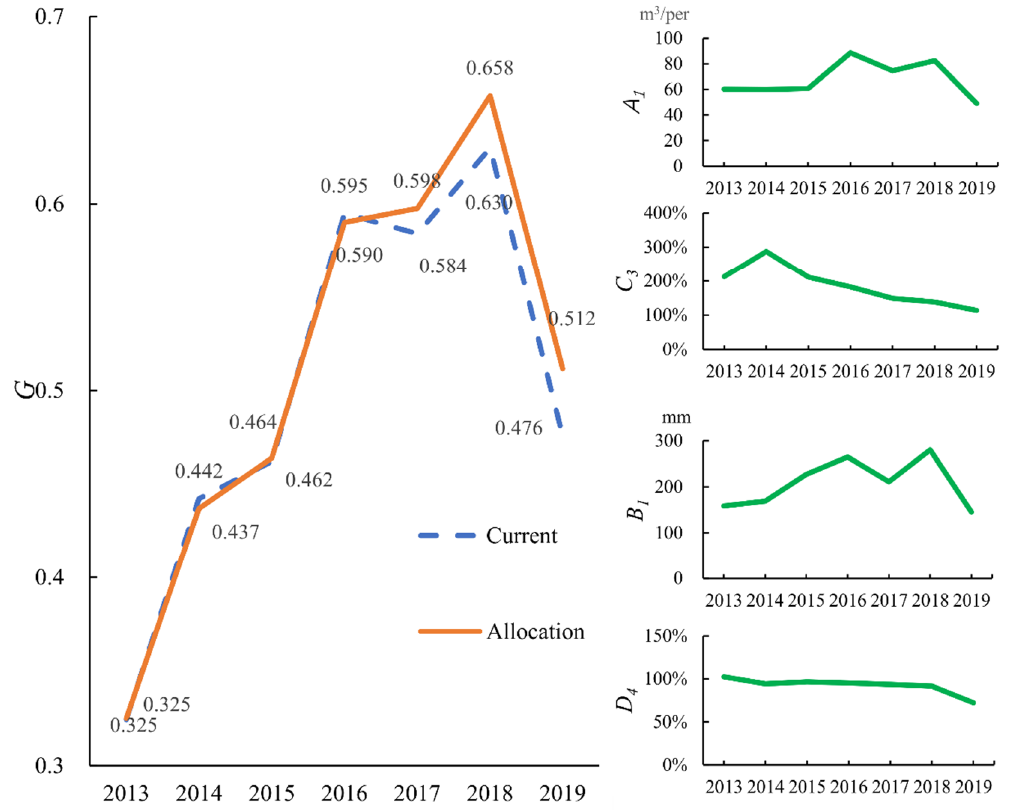
Figure 3. Trend and comparison of the water–ecology–energy–food coordinated development index in Yinchuan city from 2013 to 2019 under different water rights conditions.